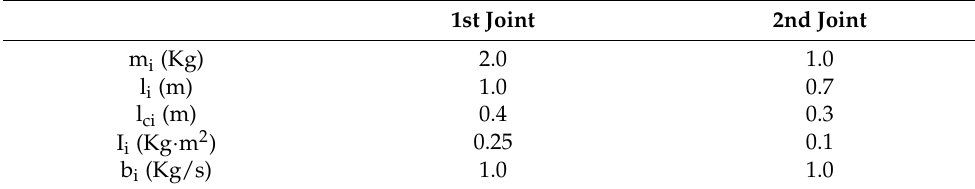
Table 6. Robot parameters implemented in the